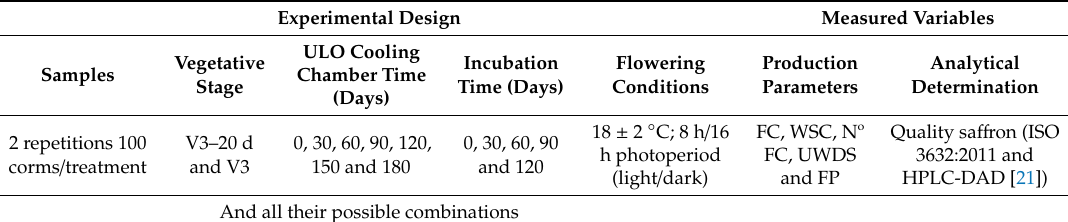
Table 1. Experimental design and measured variables for the growing season